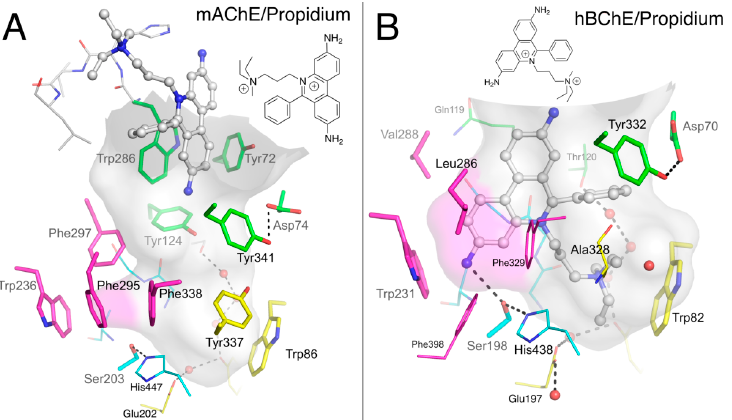
Figure 5. Cont. Figure 5.